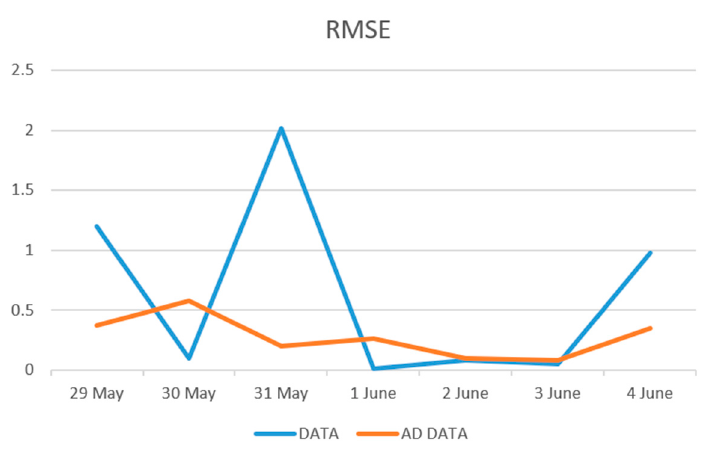
Figure 10. Root Mean Square Error (RMSE) between predicted and actual values with reference to the predictions shown in Figure 8a,b.